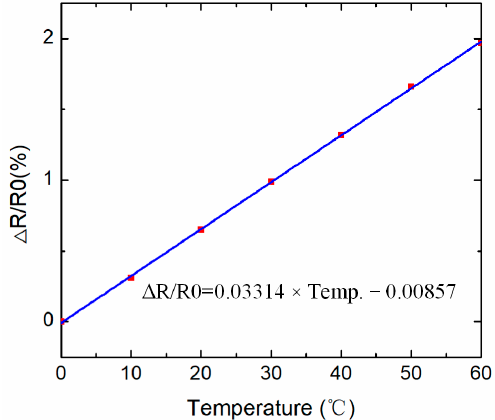
Figure 9. Temperature sensor data from the temperature sensor agent.